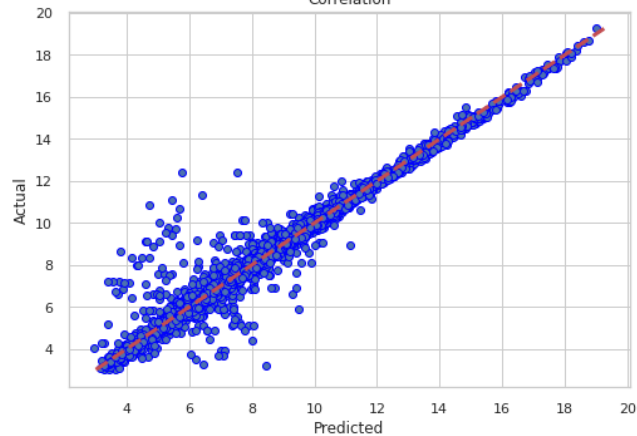
Figure 12. Correlation of the Ridge regression predictions in ms − 1 .